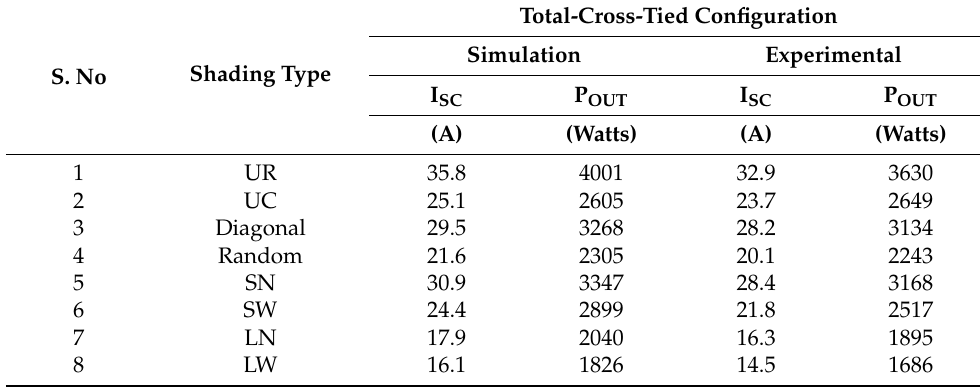
Table 4. Output Power of Total-Cross-Tied Array Configuration.